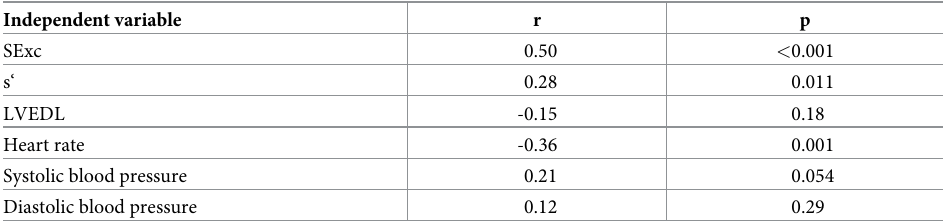
Table 2. Univariate correlations with the absolute value of GLS.